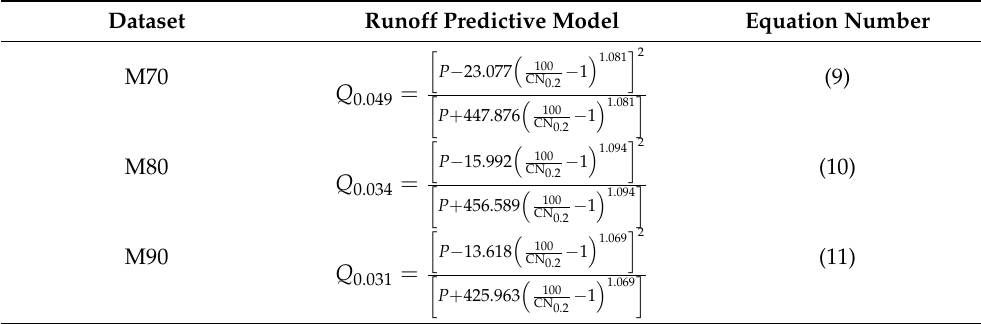
Table 10. Alternate form of decadal rainfall-runoff models for M70, M80 and M90 decadal datasets.